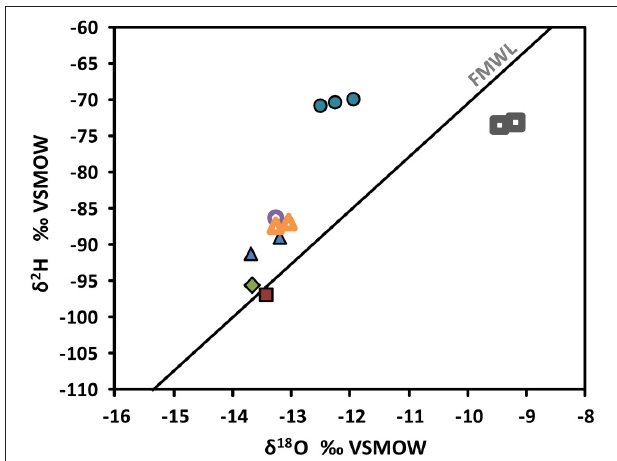
FIGURE 4 | Stable isotope compositions of groundwaters in the Pyhäsalmi mine. Values are given in h relative to Vienna Standard Mean Ocean Water (VSMOW). FMWL, Finnish Meteoric Water Line (Kortelainen, 2007 ) depicts the average composition of precipitation in Finland. Most of the samples plot left from the FMWL. This is typical for deep saline groundwaters within crystalline rocks, which have been modified by water-rock interaction (e.g., Frape et al., 2003). Circles = R-2247, open circle = R-2250, triangles = R-2227, open triangles = R-2229, diamond = PH-101, square = R-2222, open squares = drilling water from Lake